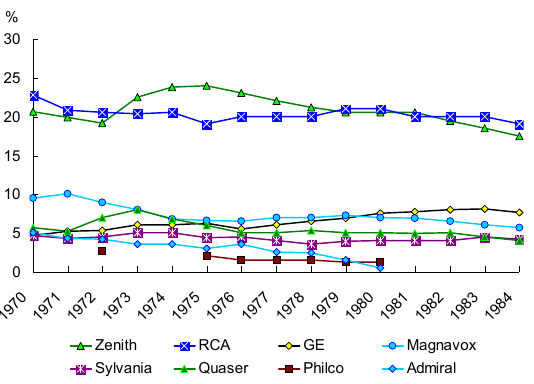
Figure 4. Color TV Market Share in U.S.